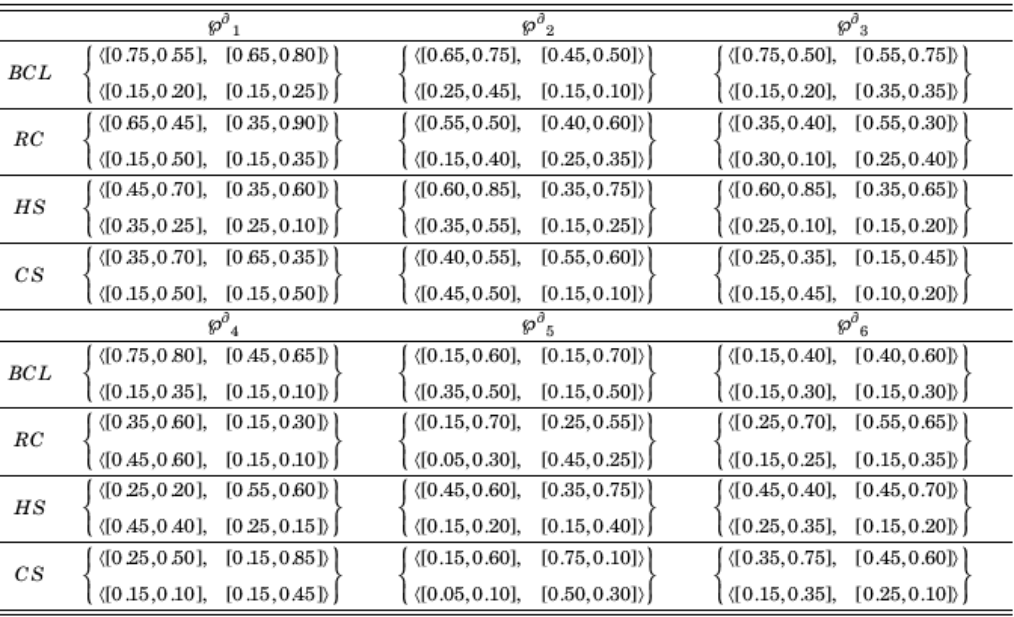
Figure 1. Decision matrix in the form of IVLDFNs.